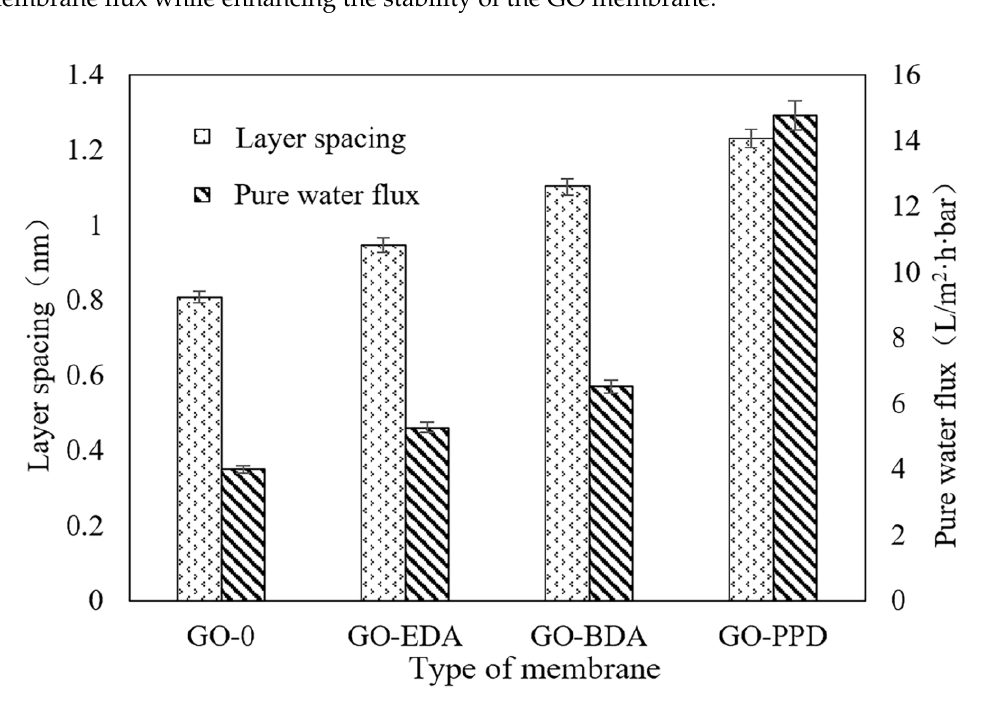
Figure 5. Pure water flux and layer spacing of cross-linked GO membrane.